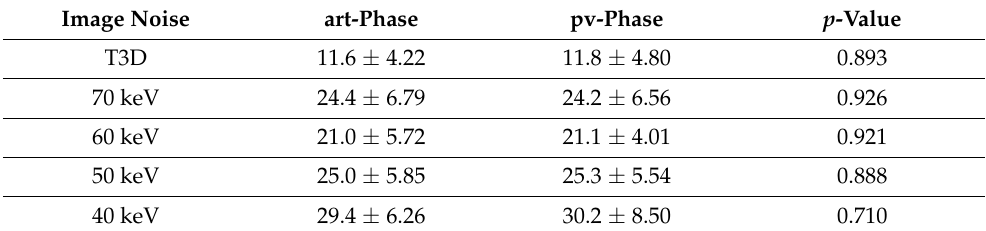
Table 6. Image noise (standard deviation of the psoas muscle).